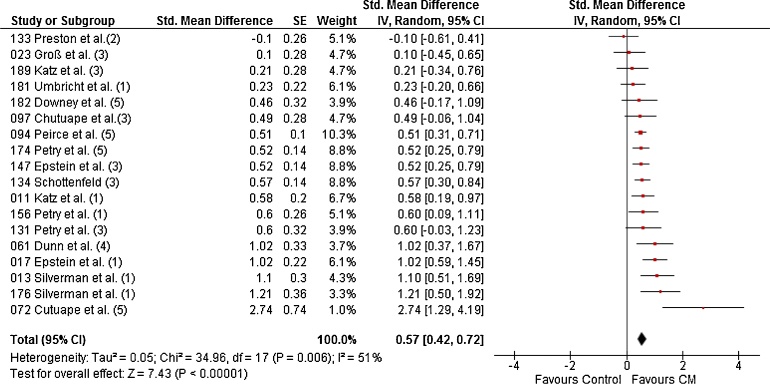
Forest plot for LDA during treatment of all substances combined. (1) = Cocaine, (2) = opiates, (3) = opiates and cocaine, (4) = Tobacco, (5) = Poly-substance.